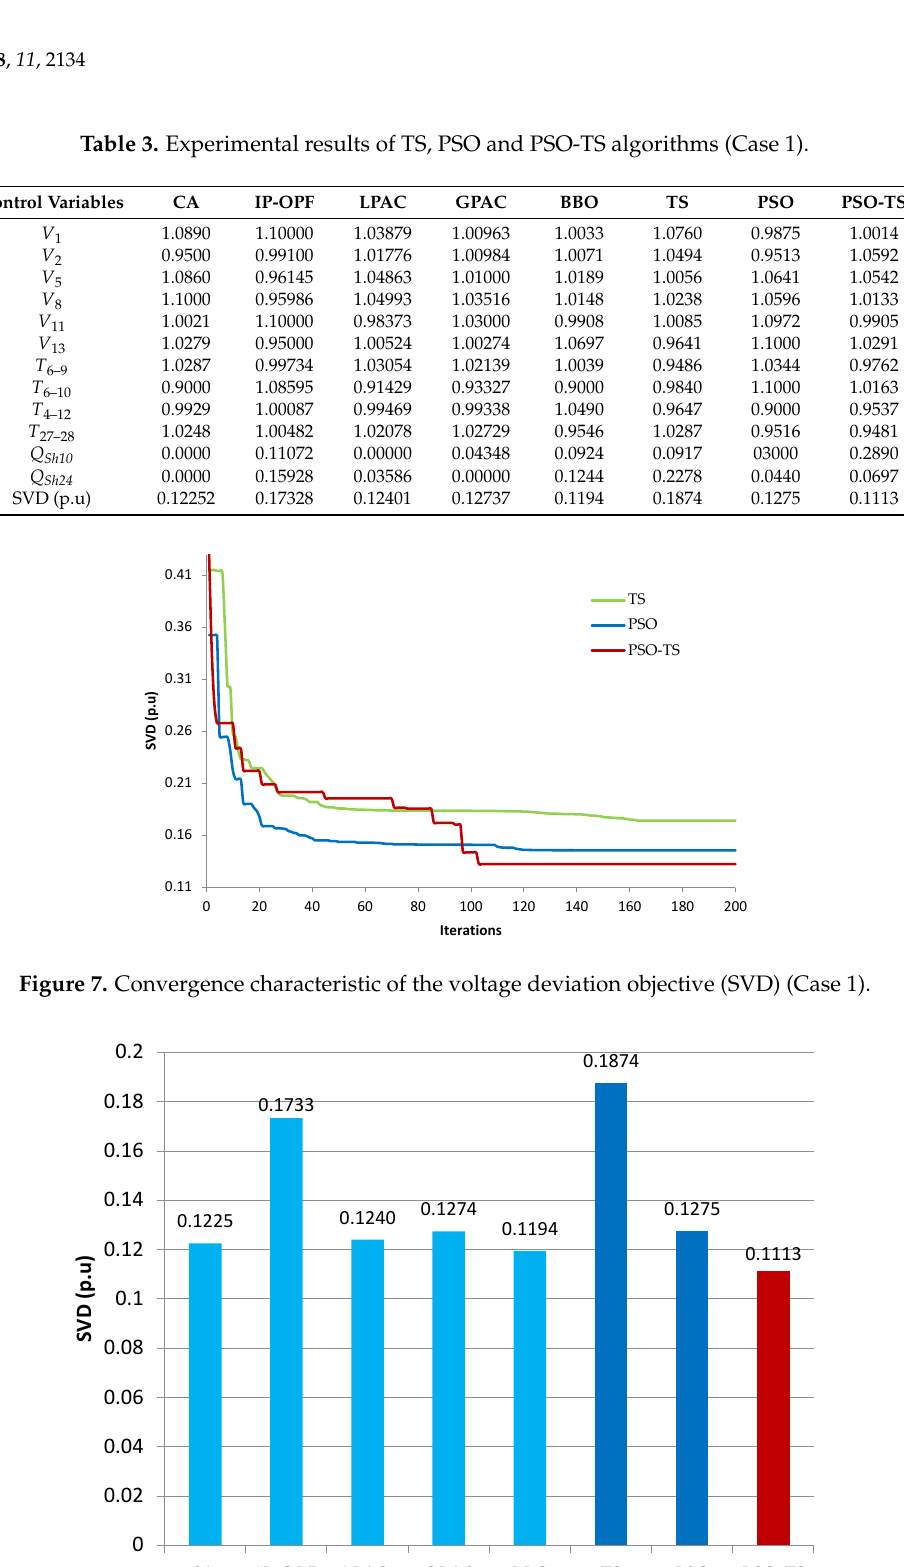
Figure 8. Comparative graph of the voltage deviation objective (SVD) (Case 1).